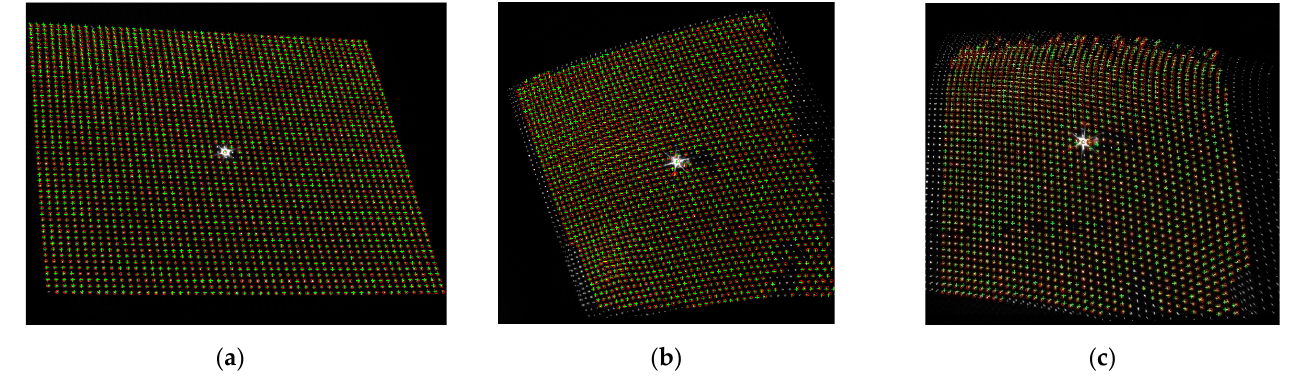
Figure 17. Positive indications of marker pairs were recorded for the medium range of searches (10 px) with the removal of points on pairs of images characterized by ( a ) small deformation, ( b ) medium deformation, and; ( c ) large deformation.